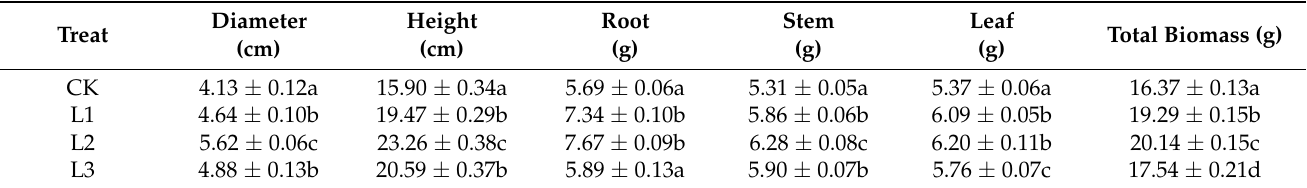
Table 1. Growth of seedlings in different N fertilization treatments. Diameter and height are